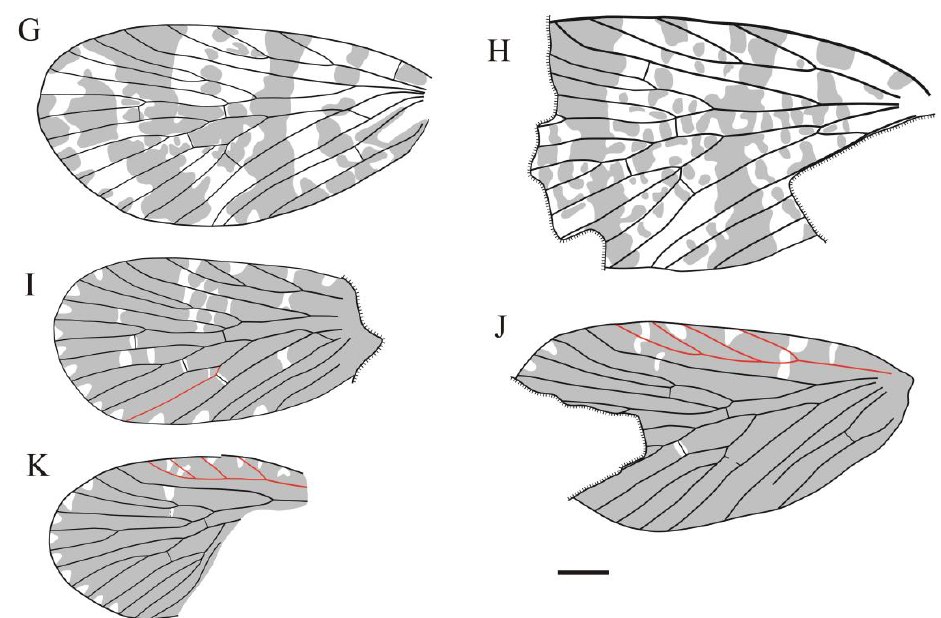
Figure 19. Line drawings of all sinoagetopanorpid species: ( A ) Sinoagetopanorpa permiana Lin, Nel and Huang, 2010, NIGP200888 (paratype); ( B ) S. nigra sp. nov., NIGP200912 (holotype); ( C ) S. rotunda sp. nov., NIGP200913 (holotype); ( D ) S. lini sp. nov., NIGP200917 (paratype); ( E ) S. minuta sp. nov., NIGP200920 (holotype); ( F ) S . elegans sp. nov., NIGP200921 (holotype); ( G ) S . grimaldii sp. nov., NIGP200922 (holotype) (mirror image); ( H ) S . magna sp. nov., NIGP20926 (holotype); ( I ) Raragetopanorpa zhangi sp. nov., NIGP200927 (holotype); ( J ) Permoagetopanorpa yinpingensis sp. nov., NIGP200928 (holotype); ( K ) P. incompleta sp. nov., NIGP200929 (holotype). Scale bar represents 1 mm.